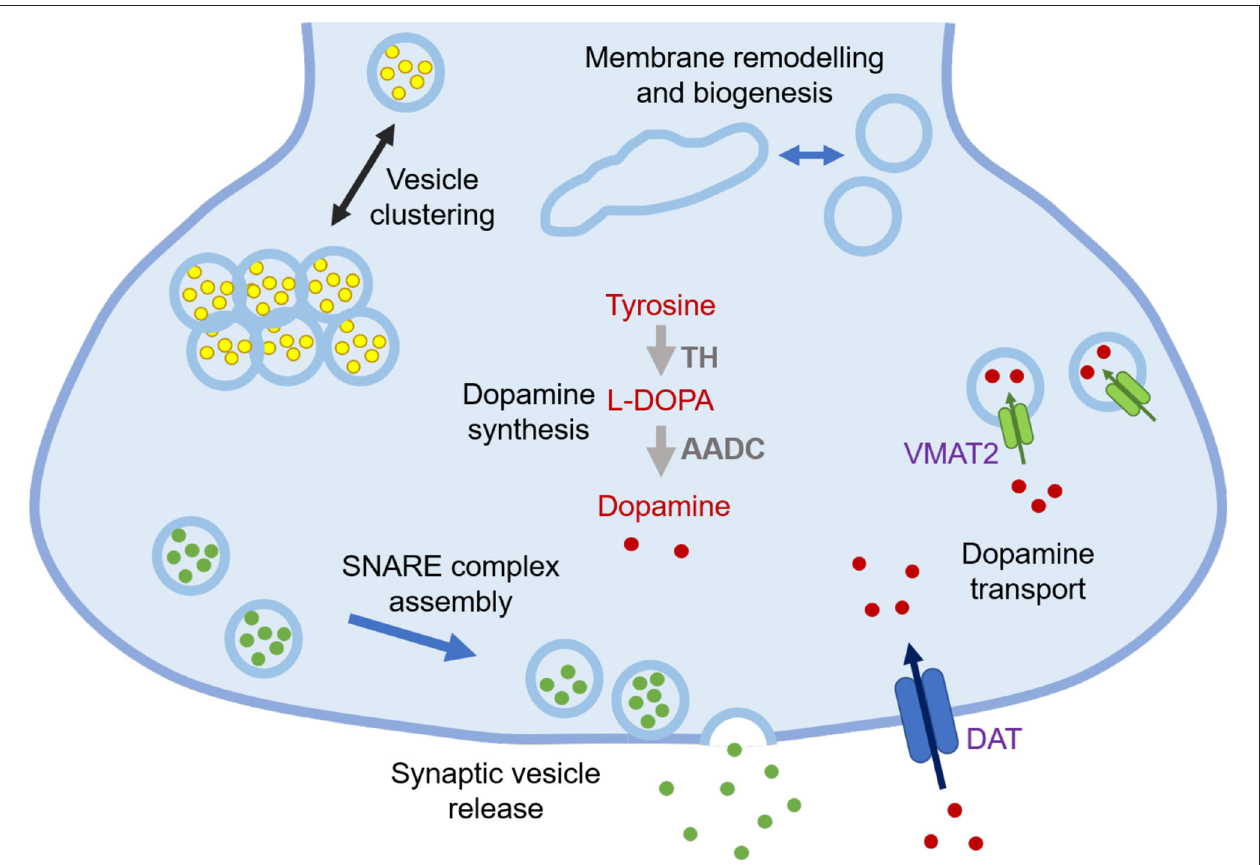
FIGURE 1 | Schematic illustration of currently known functions of α -synuclein at synapses. The functions of α -synuclein are still to be fully elucidated, but at synapses they may include lipid-related functions, such as regulation of synaptic vesicle pools via sorting and clustering, remodelling of lipid membranes, in particular tubulation and biogenesis, and promotion of SNARE complex assembly and synaptic vesicle release, as well as non-lipid related functions, including modulation of dopamine synthesis via tyrosine hydroxylase (TH) that converts tyrosine into L-3,4-dihydroxyphenylalanine (L-DOPA) and regulation of dopamine transport through dopamine transporter (DAT) and vesicular monoamine transporter (VMAT2) ( 7, 8).